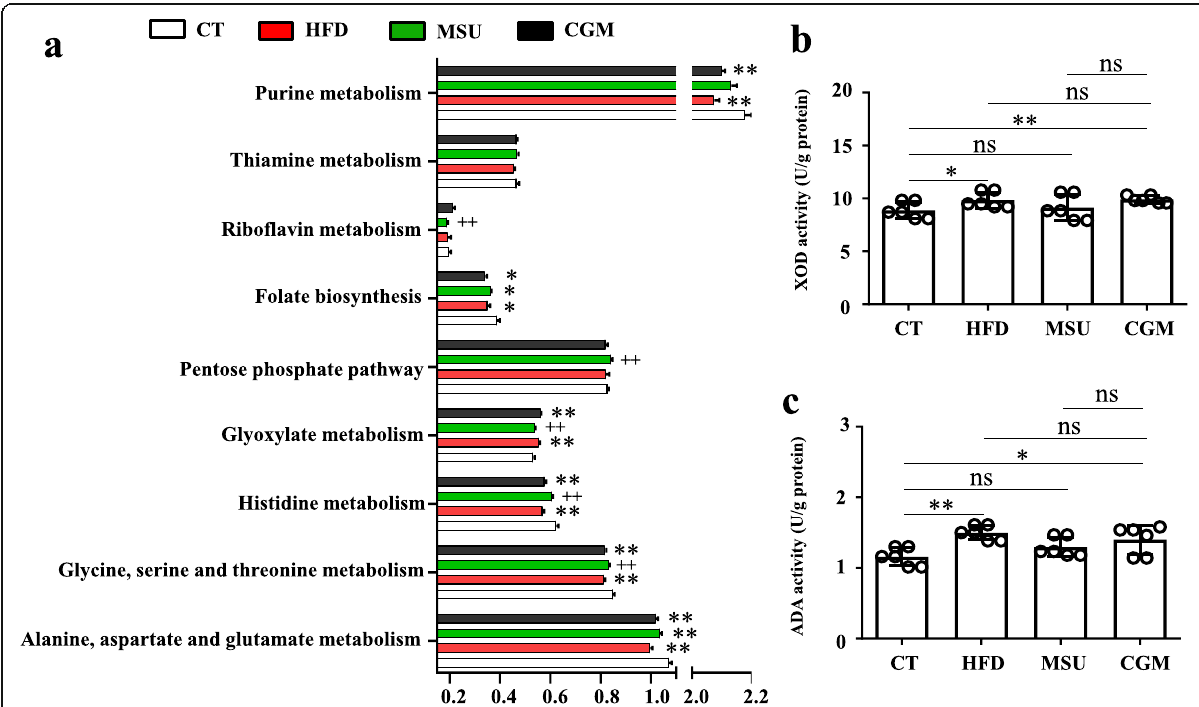
Fig. 6 Purine metabolism of gut microbiota ( a ) and liver [XOD activity ( b ); ADA activity ( c )] of mice in the four groups. Gene functional categories were from level 3 of KEGG pathways and involved in purine metabolism. “ ns ” represents not significant; “ * ” represents p <0.05 in comparison with CT; and “ ** ” represents p <0.01 in comparison with CT; “ + ” represents p <0.05 in comparison with CGM; and “ ++ ” represents p <0.01 in comparison with CGM. CT: control group; HFD: hyperuricaemia model; MSU: acute gout model; CGM: compound gout